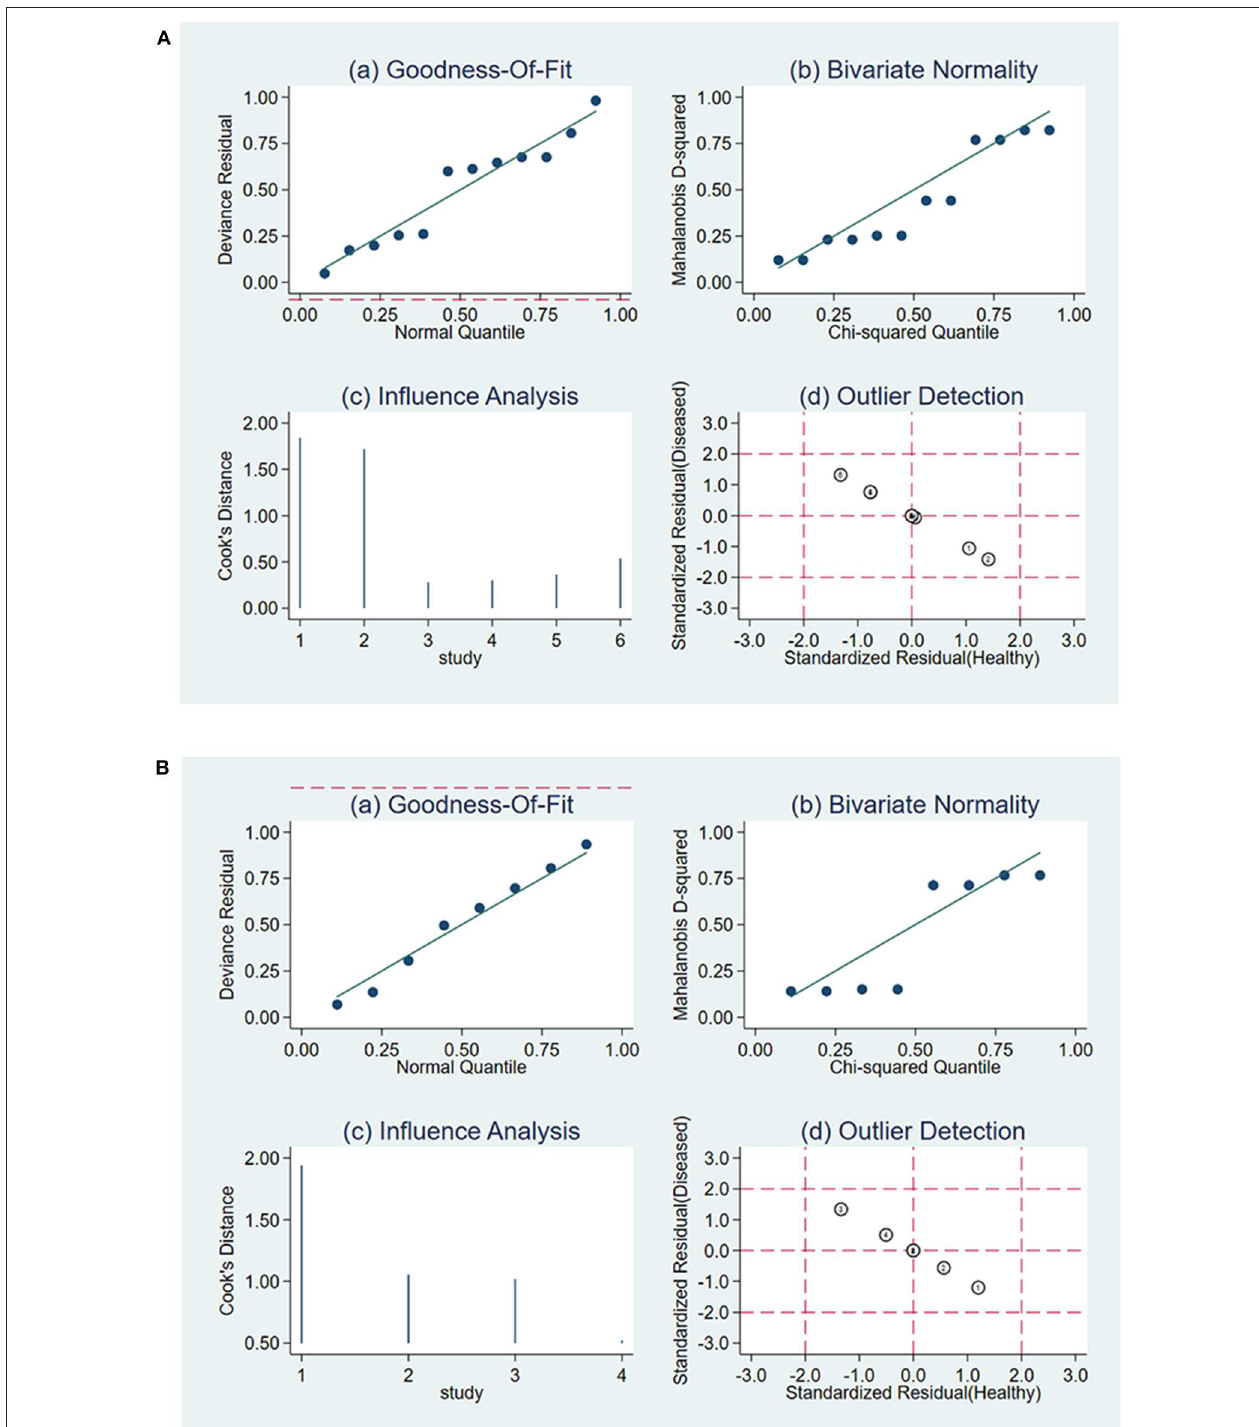
FIGURE 7 | Sensitivity analysis for the uptake change ratio (A) and washout rate (B) of 99m Tc-MIBI scintigraphy in preoperatively assessing the response of osteosarcoma patients to neoadjuvant chemotherapy.